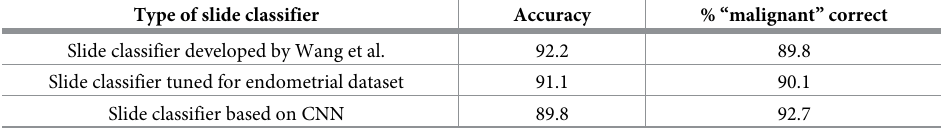
Table 4. Accuracy and percentage of “malignant” slides correctly classified based on type of slide